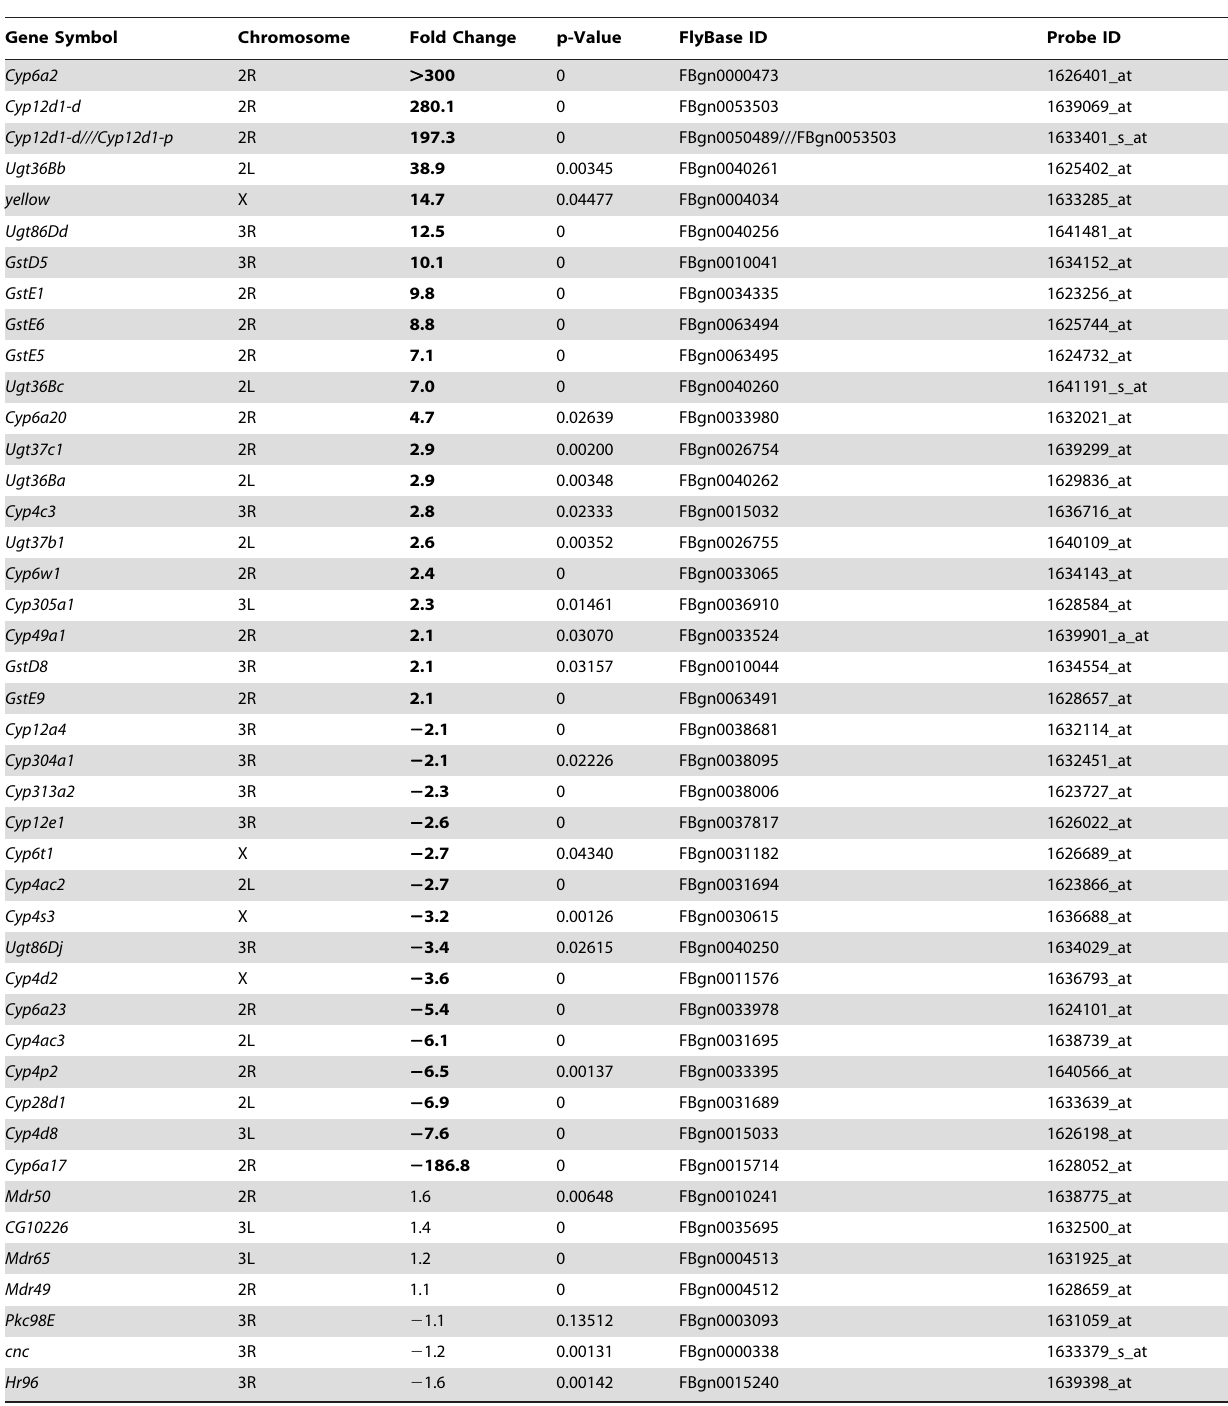
Table 1. Single gene analysis for Ama-KTT/M/2 versus Canton-S on no toxin (group 2 versus 1).